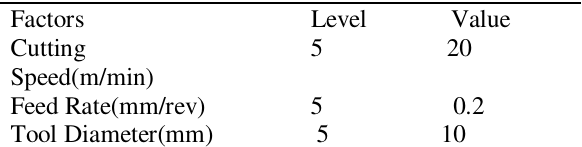
Optimal Drilling Condition